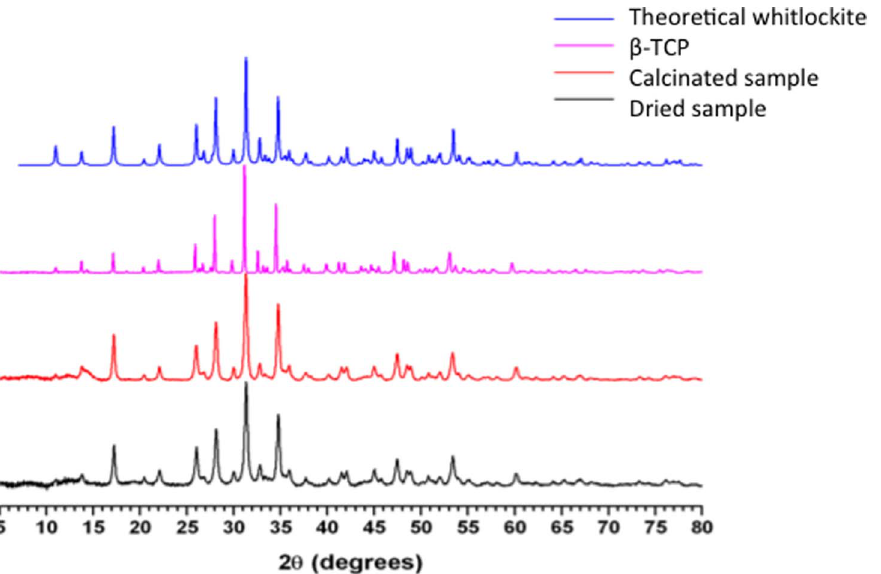
Figure 3. XRD spectra of the dried precipitate recovered after 30 days of C.hydrogenoformans growth in the DSMZ medium (identified as ‘Dried sample’), the dried sample after having been calcinated (identified as ‘Calcinated sample’), the commercial sintered b -TCP, and the whitlockite, calculated according to the JCPDS (Joint Committee on Powder Diffraction Standards) database (number 01-070-1786).